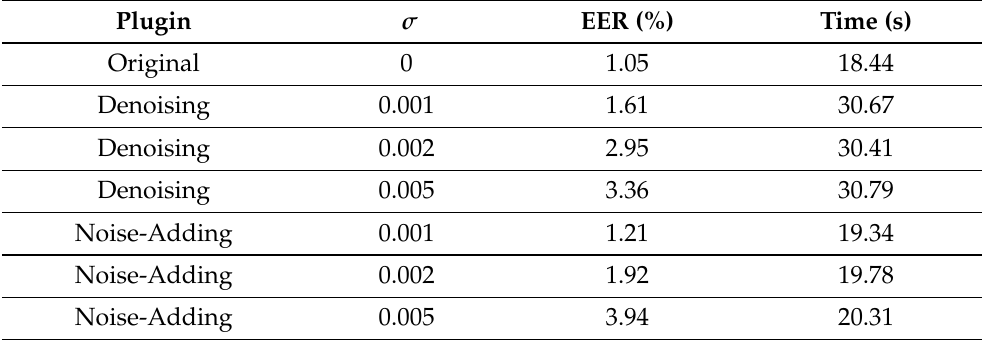
Table 1. Performance evaluation of proposed defense system on normal operations of GMM SV systems.